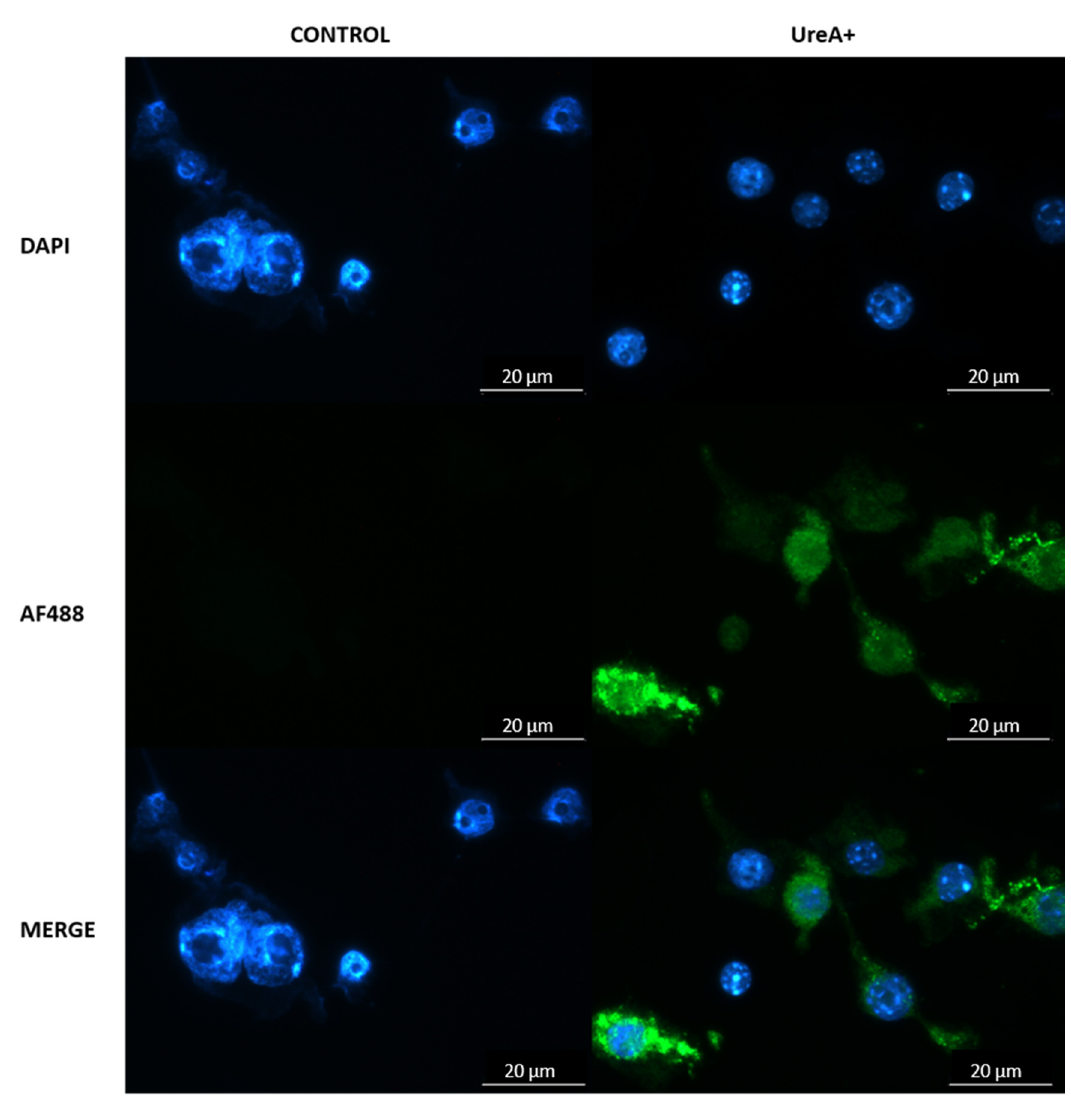
Figure 8. Fluorescence micrograph of DAPI-stained DC2.4 cells (blue; nuclei) expressing Urease alpha (UreA) labelled with AlexaFluor 488 conjugated anti-His monoclonal antibody (green). Cells were transfected with lipoplex-A (SLN-A nanoparticles loaded with pcDNA3.1-UreA) and were found to be expressing UreA protein indicated by the binding of anti-6XHis antibody. Scale bar 20 µm.